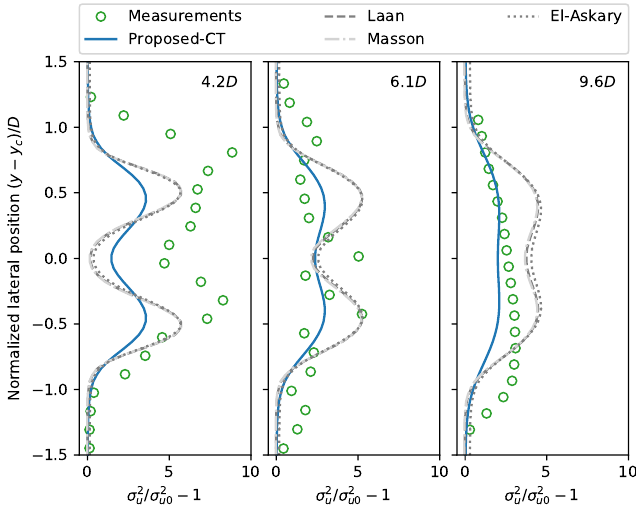
Figure 17. Lateral added turbulence in wakes of Danwin 180 kW wind turbines at hub height under the stable condition; σ u and σ u 0 represent the standard derivations of wind speed in wakes and in the atmosphere, respectively. All turbulence models are combined with AD based on thrust